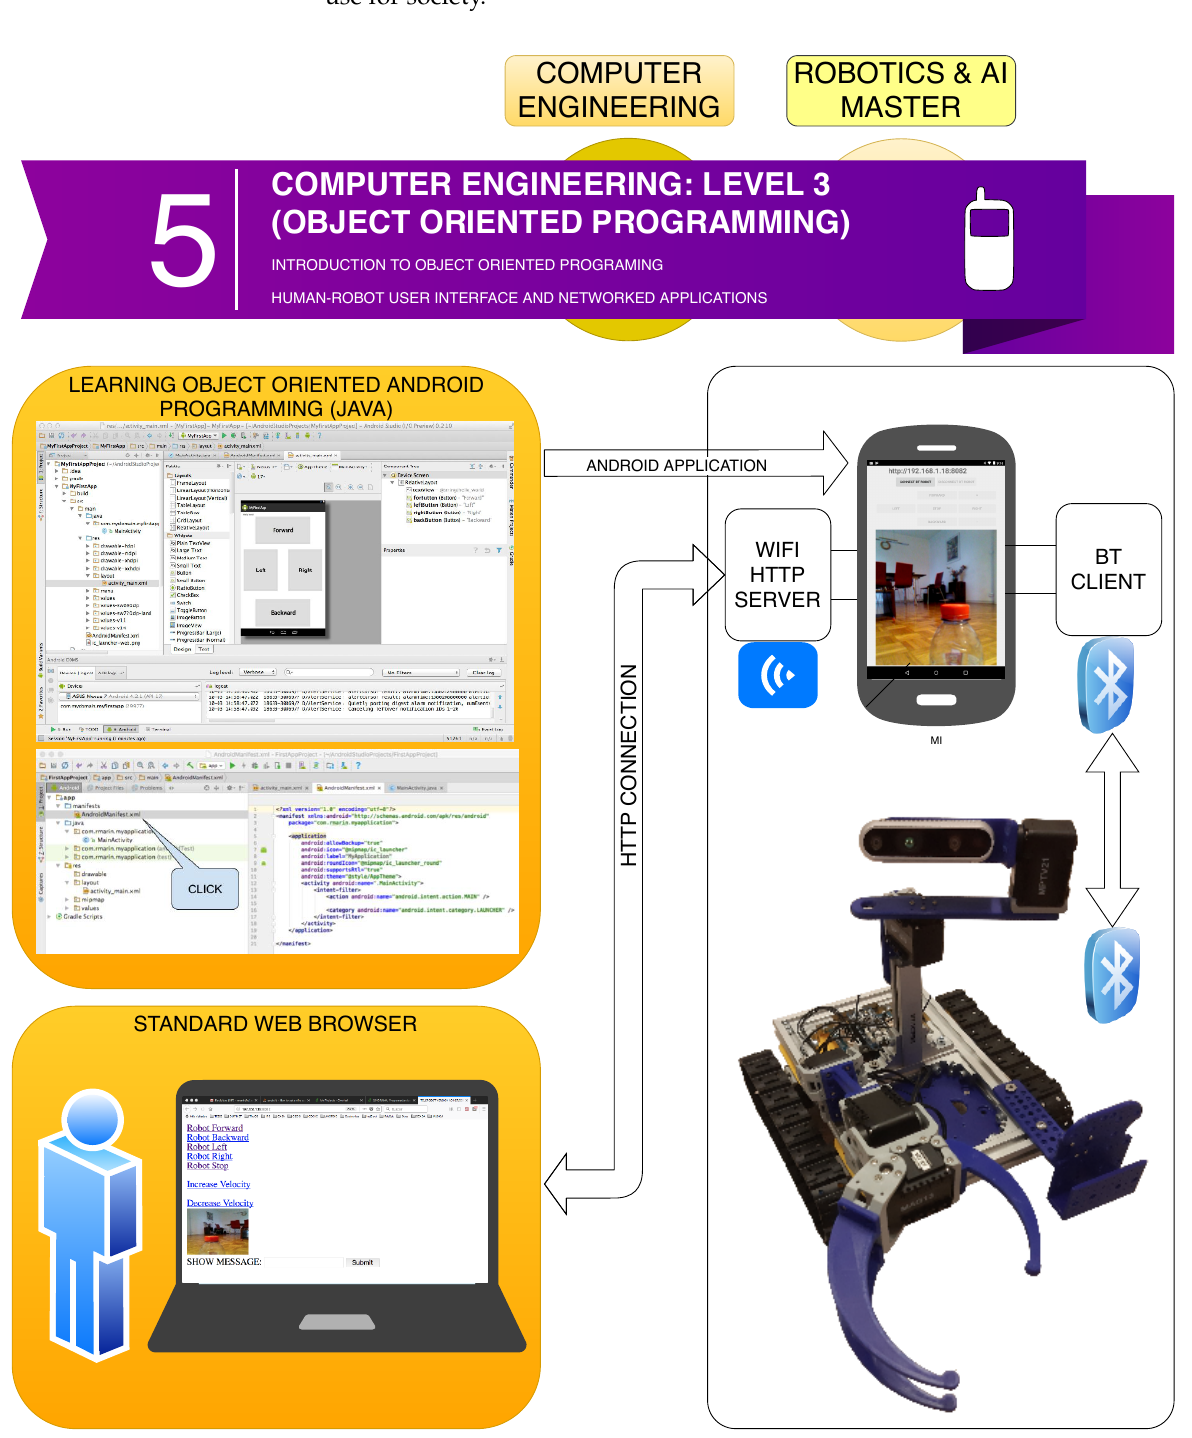
Figure 18. Software architecture to face the Level 3 learning path (i.e., Object-oriented